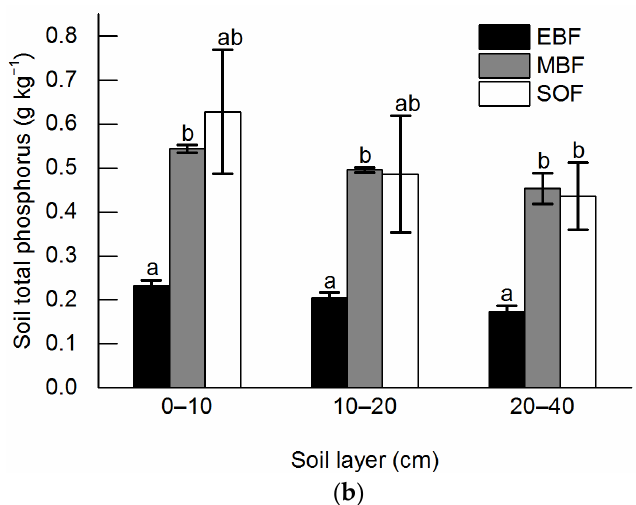
Figure 4. Contents of soil total nitrogen ( a ) and total phosphorus ( b ) in three forest types at different depths. Different lowercase letters (a, b) above each bar indicate significant differences among different forest types ( p < 0.05), the same letters indicate no significant differences between each other, and two repeated letters (ab) indicate that the forest type is not significantly different from the other two types. Vertical bars show ± S.E.